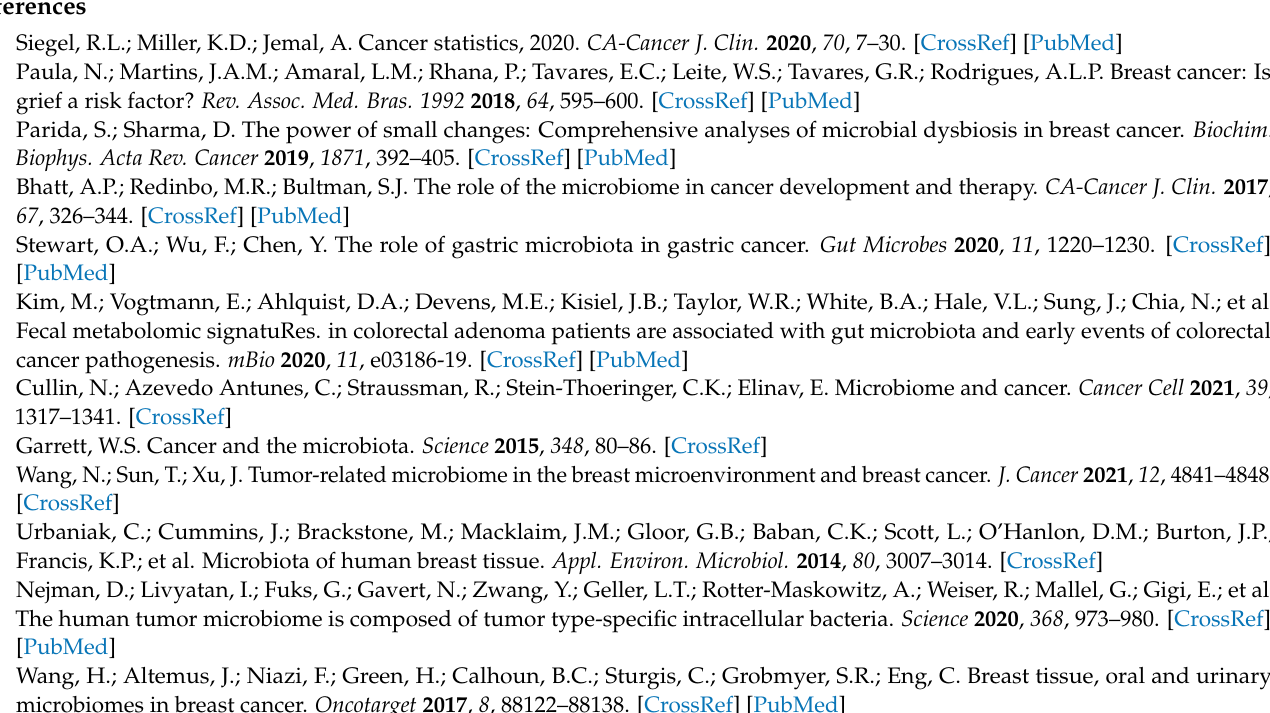
Table S2: Raw and processed read counts per sample for sequencing; Table S3: Number of different taxa detected in different groups; Figure S1: Relative abundance of bacterial phyla within all breast tissues; Figure S2: The first 20 species of bacteria with relative abundance fluctuate between benign tissue (L), normal tissue (P), and breast tumor tissue (C), and the length of a colored box represents the relative abundance of that organism within each